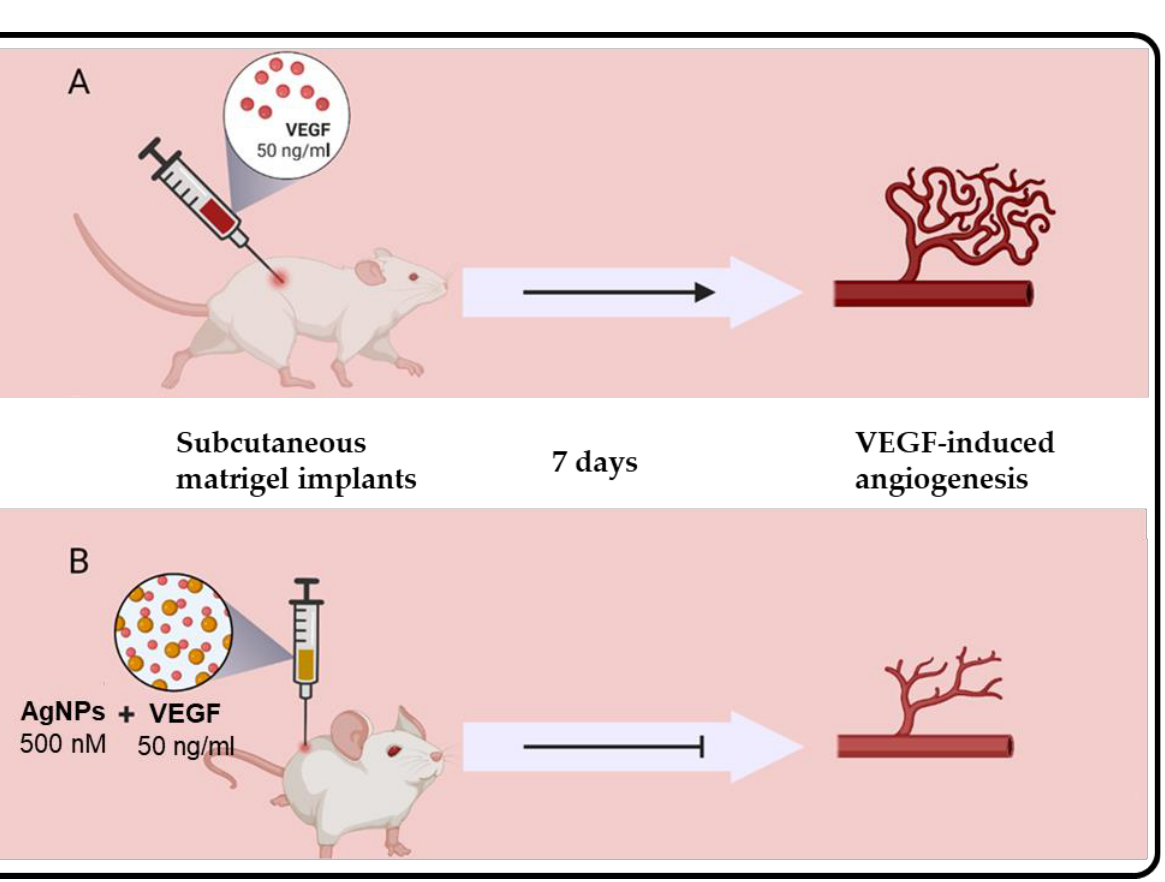
Figure 5. Anti-angiogenic effects of AgNPs in vivo using a matrigel plug model with BRECs. Matrigel plugs containing BRECs with and without 50 ng/mL VEGF were implanted into mice for 7 days. Angiogenesis occurred in mice treated with VEGF alone ( A ). The AgNPs inhibited the VEGF-induced angiogenesis in mice implanted with matrigel plugs containing BRECs with 50 ng/mL VEGF and 500 nM AgNPs after 7 days ( B ). Adapted from [99].